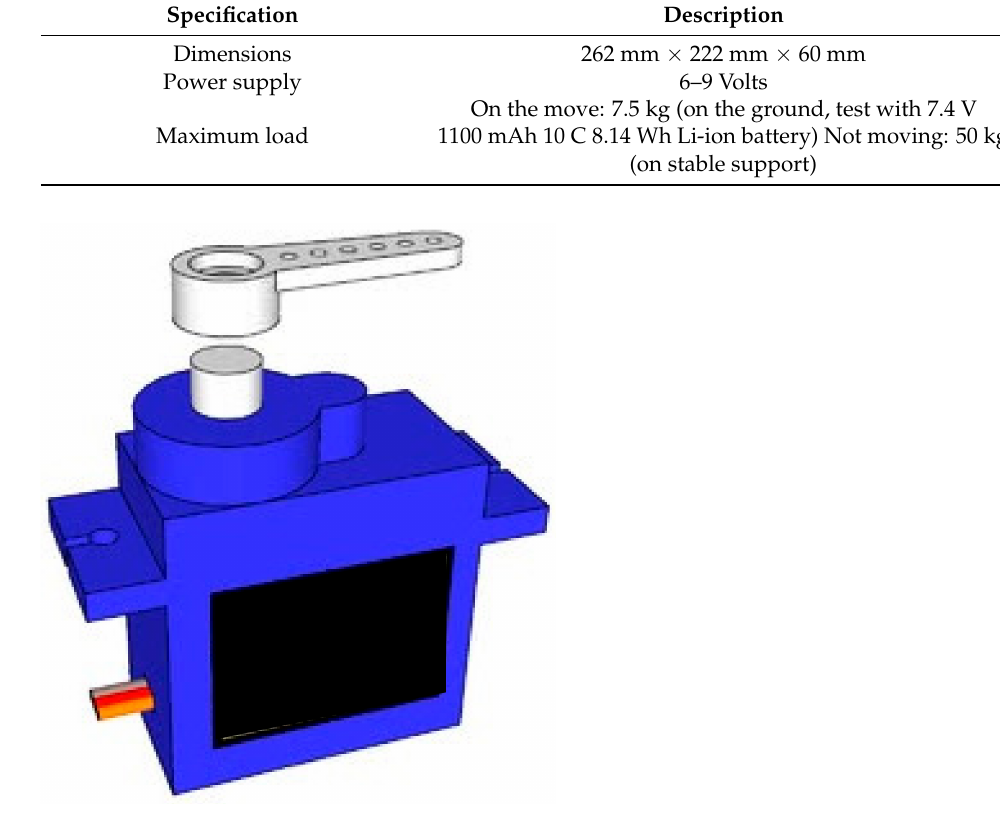
Figure 7. Servo drive. Table 7. Specifications of Servo